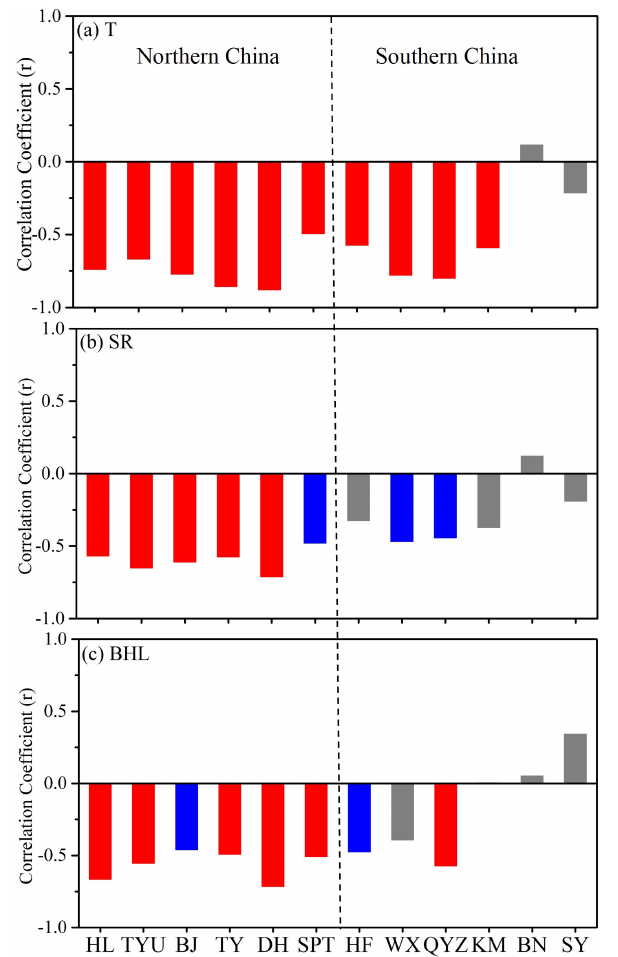
Figure 4. Correlation coefficient ( r ) of PAHs with T (a) , SR (b) and BLH (c) at 12 sites. The red, blue and gray bars indicate p < 0 . 01, p < 0 . 05 and p > 0 . 05, respectively.